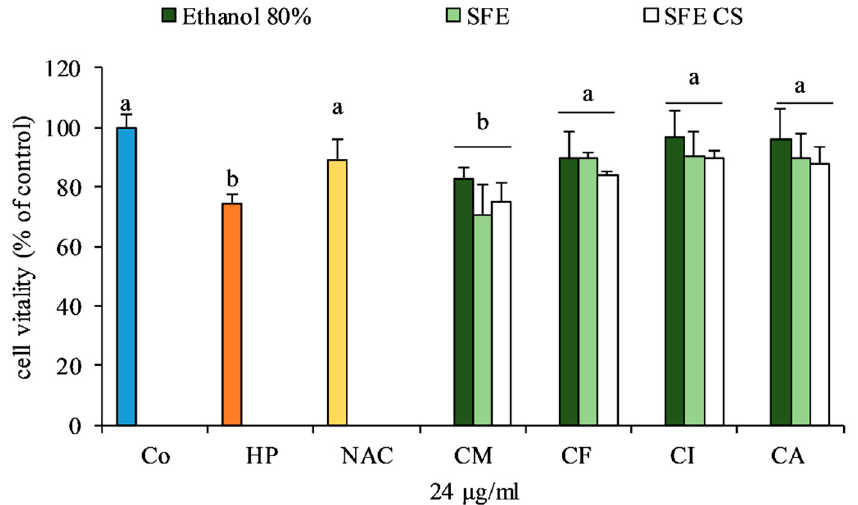
Figure 6. Effect of Calendula extract on fibroblast cells exposed to oxidative stress, induced by H 2 O 2 Co = control cells; HP = cells treated only with HP hydrogen peroxide, without extracts; NAC = cells pretreated with the synthetic antioxidant NAC and then exposed to HP; CM = cells pretreated with different extracts of C. maritima and then exposed to HP; CF = cells pretreated with different extracts of C. suffruticosa subsp. fulgida and then exposed to HP; CI = cells pretreated with different extracts of C. hybrid ( maritima × fulgida )and then exposed to HP; CA = cells pretreated with different extracts of C. arvensis and then exposed to HP. Lowercase letters indicate significant differences (a, b, c: p < 0.05) according to the analysis of variance (ANOVA).